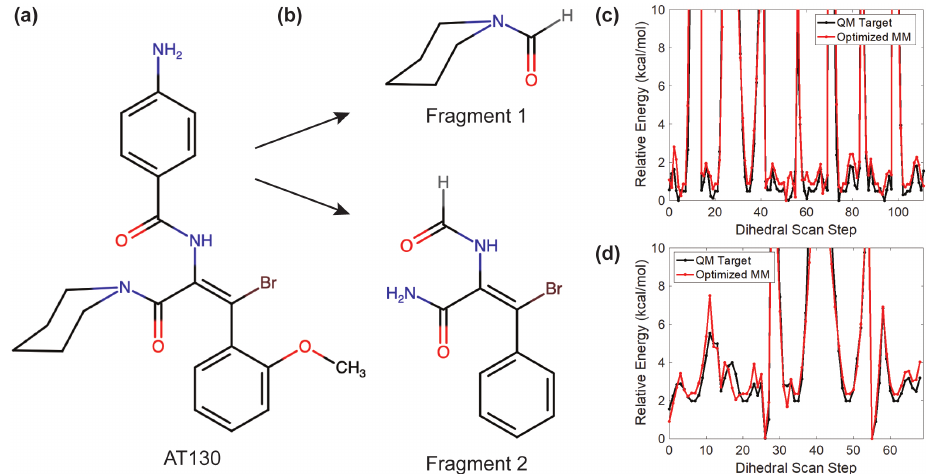
Figure 2. Parameterization of AT130. ( a , b ) The phenylpropenamide derivative AT130 was divided into two minimal fragments for QM calculations. ( c , d ) Optimized dihedral parameters show accurate reproduction of QM rotational